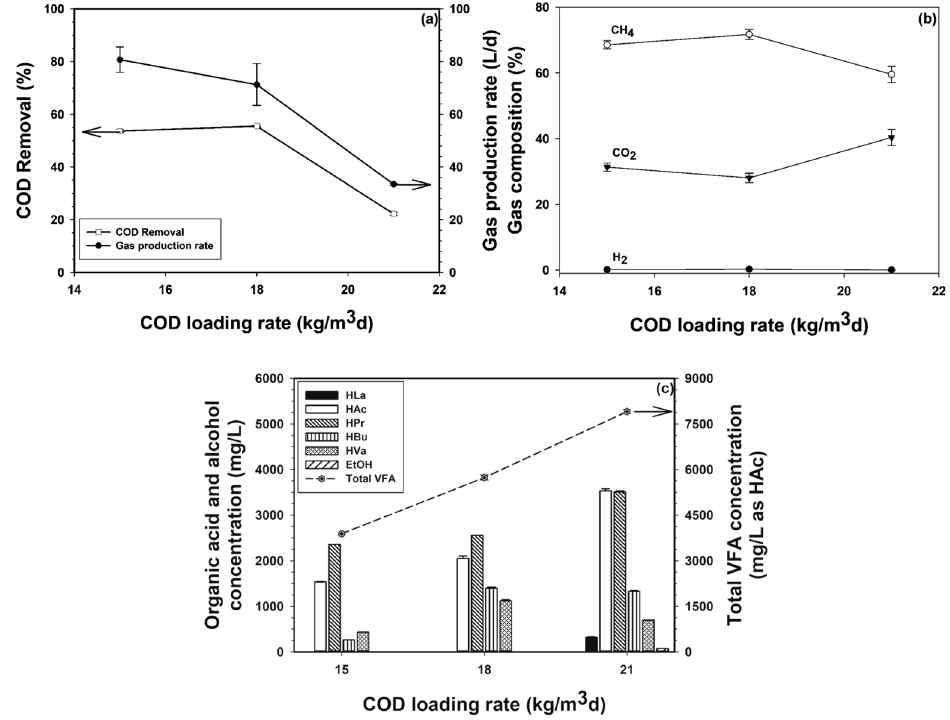
Figure 3. Effect of the COD loading rate on the ( a ) COD removal and gas production rate, ( b ) gas composition and ( c ) total VFA concentration and VFA composition of the second bioreactor operated at 37 °C and 6 cycles/d.